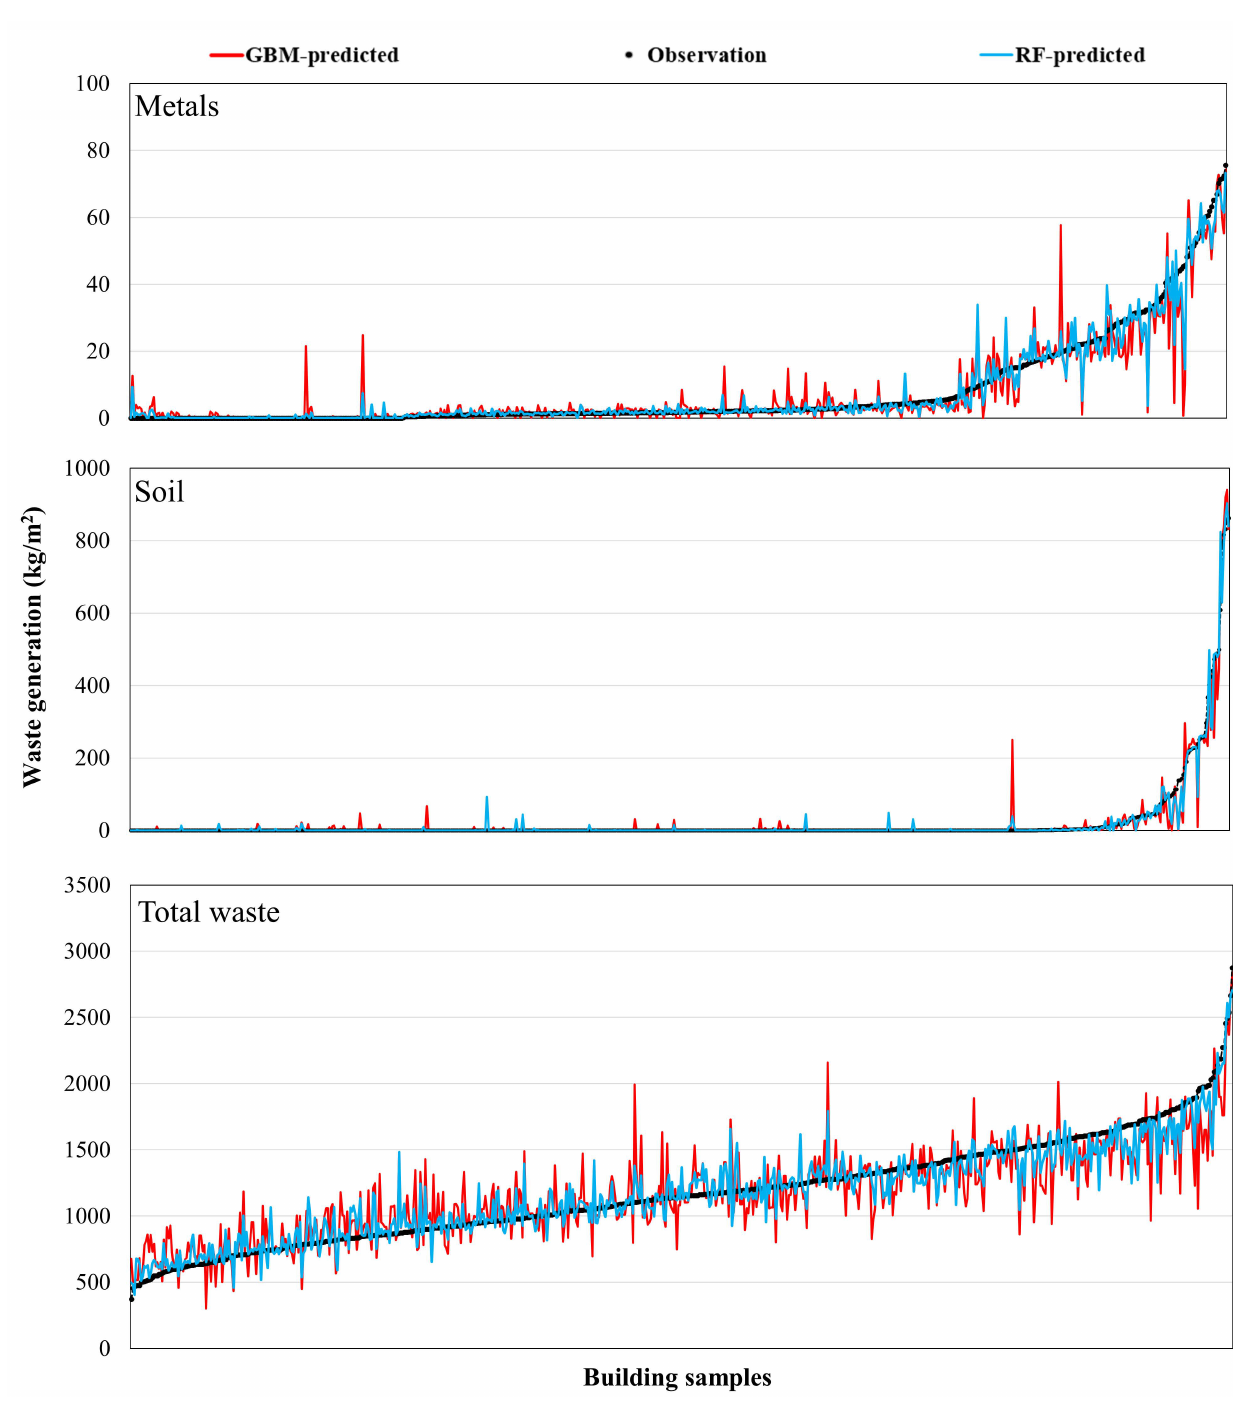
Figure 8. Comparison of the observed and predicted DW generation (kg/m 2 ) with the estimated ML models using RF and GBM for metal, soil, and total